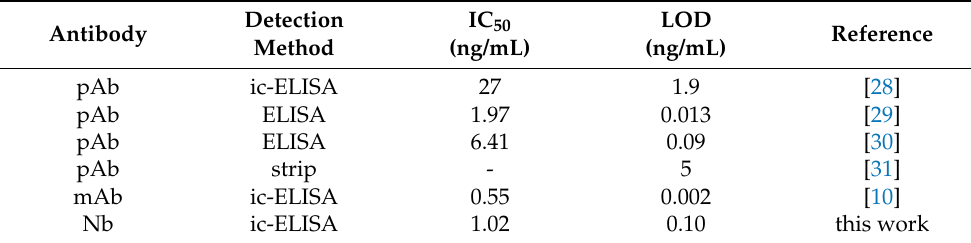
Table 2. Sensitivity of Reported Anti-19-NT Reagents.